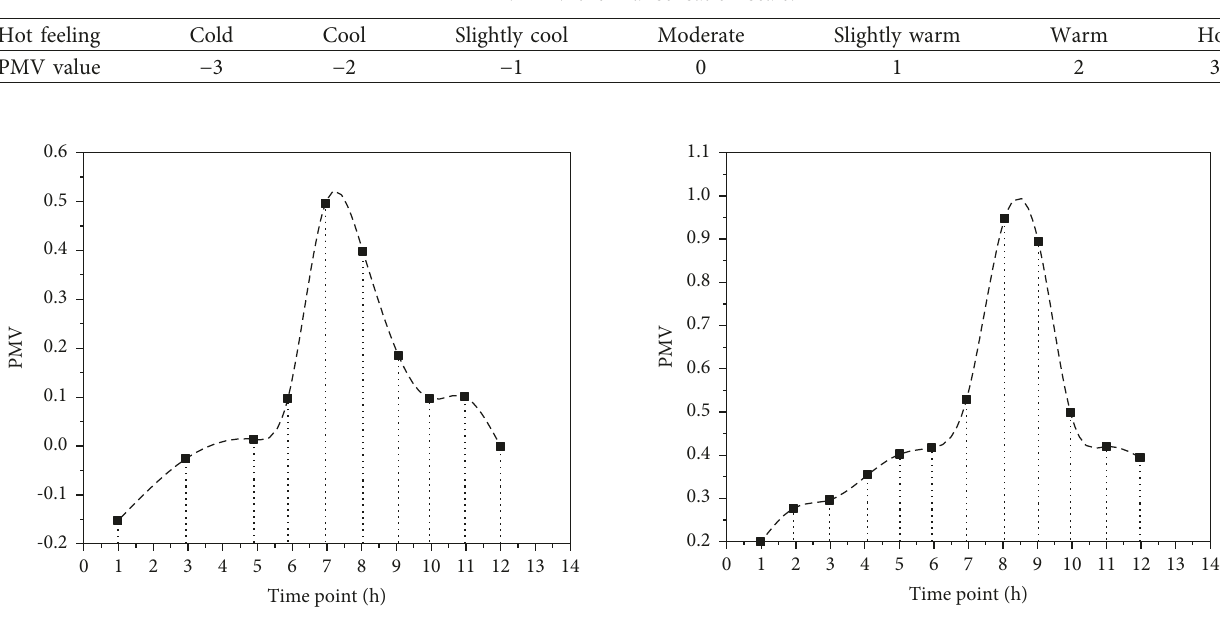
Table 1: PMV thermal sensation scale.